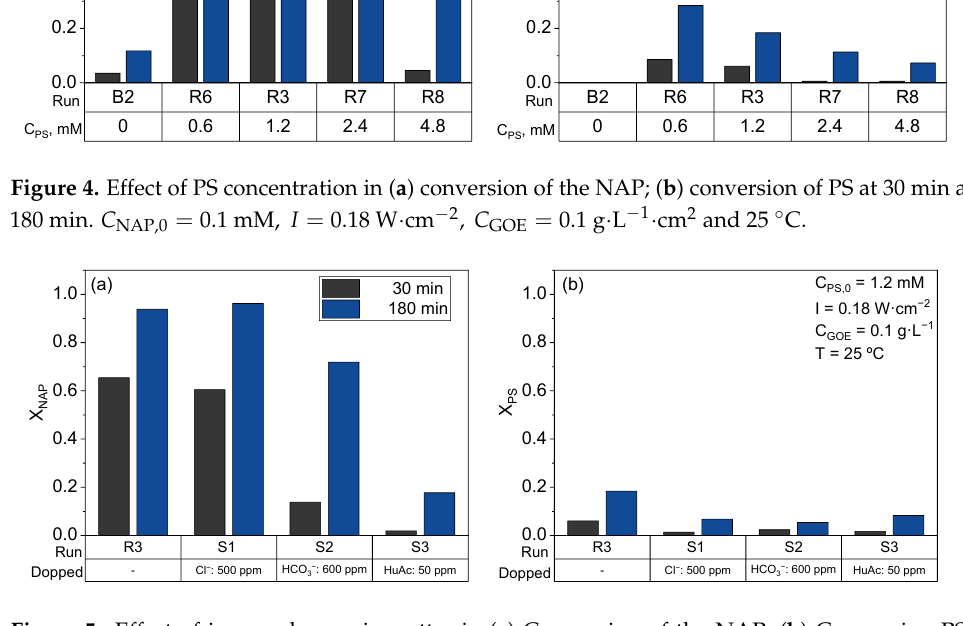
Figure 5. Effect of ions and organic matter in ( a ) Conversion of the NAP; ( b ) Conversion PS at 30 min and 180 min. 𝐶 NAP,0 = 0.1 mM,𝐼 = 0.18 W · cm −2 , 𝐶 GOE = 0.1 g · L −1 · cm 2 , 𝐶 PS,0 = 1.2 mM, 𝑝𝐻 0 = 7 and 25 ℃.